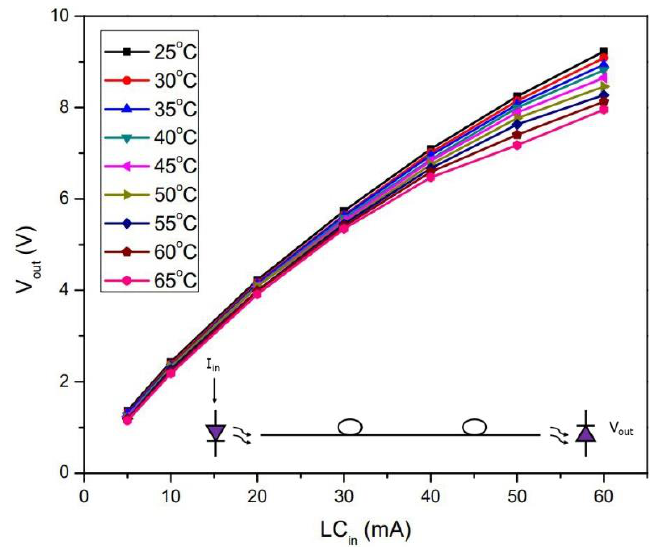
Figure 7. The temperature drift of the sensor from 25 °C to 65 °C, considering the input current on the green LED, varying from 0 to 60 mA, and using a 50-m length of POF cable.